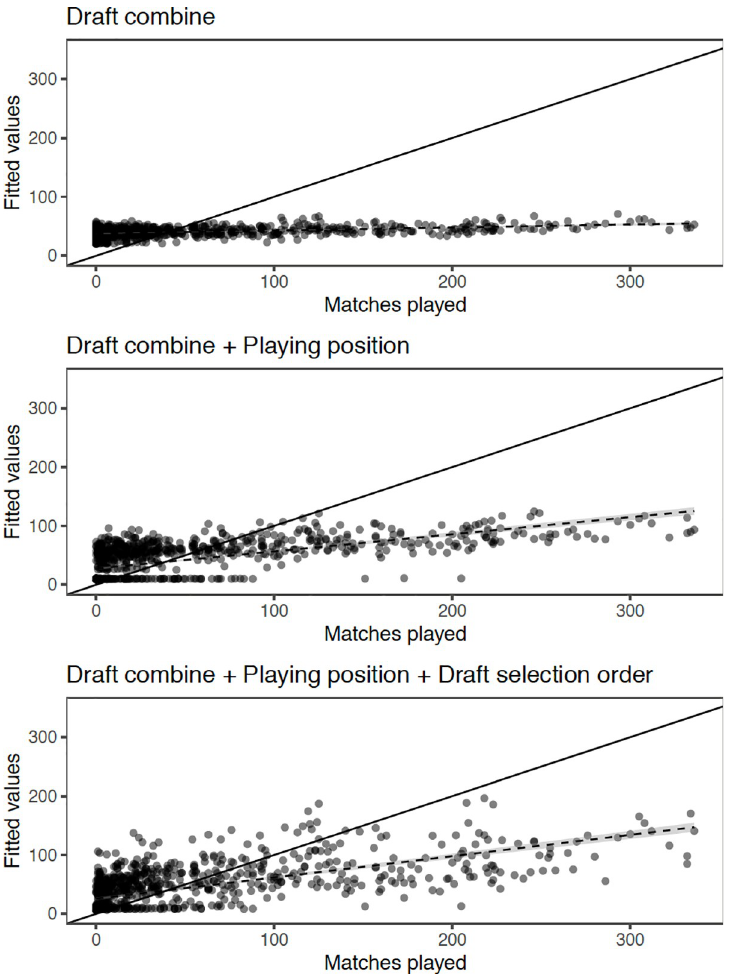
Fig 3. Boosted regression tree scatterplot of matches played and the fitted values of each model. Combinations of predictor variables as follows; combine, combine + playing position, combine + playing position + draft selection